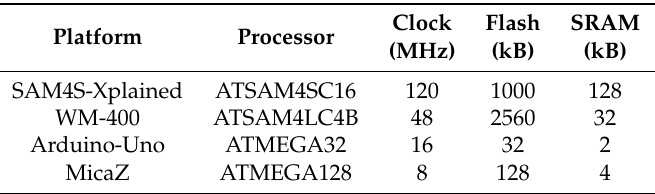
Table 4. COTS Nodes architecture.